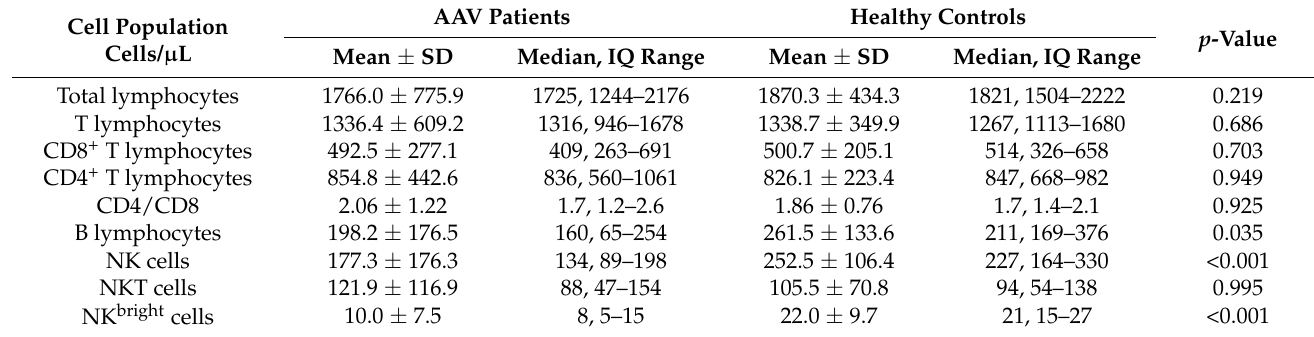
Table 2. General lymphocytes populations in the AAV patients and the healthy controls.